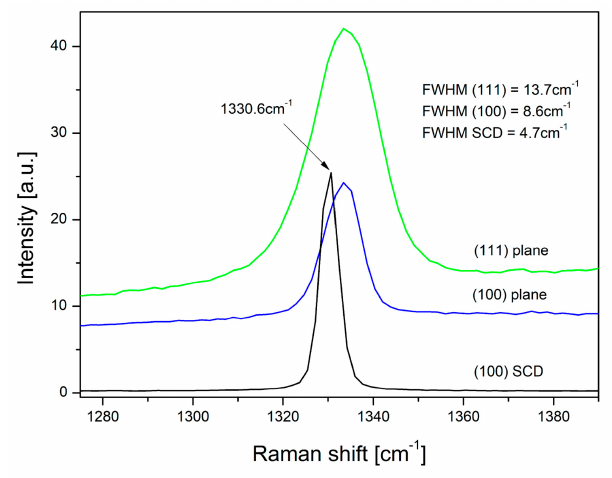
Figure 3. The Raman spectra for Element Six diamond monocrystal, and spectra taken from (100) and (111) planes of HF CVD diamond